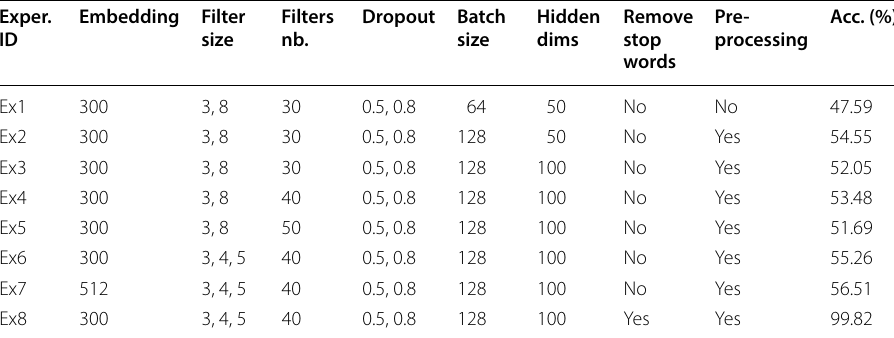
Table 4 Training